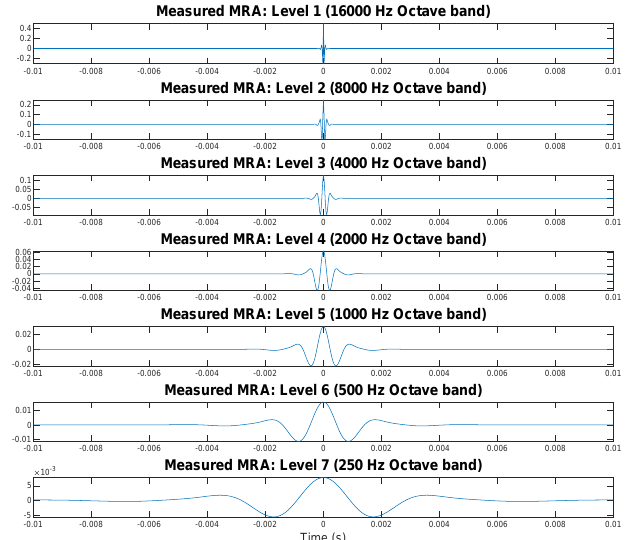
Figure 5. Multi-resolution analysis (MRA) of impulse (45,254 Hz sample rate) using Daubechies (db6) wavelet. Levels 1–7, represent octave bands